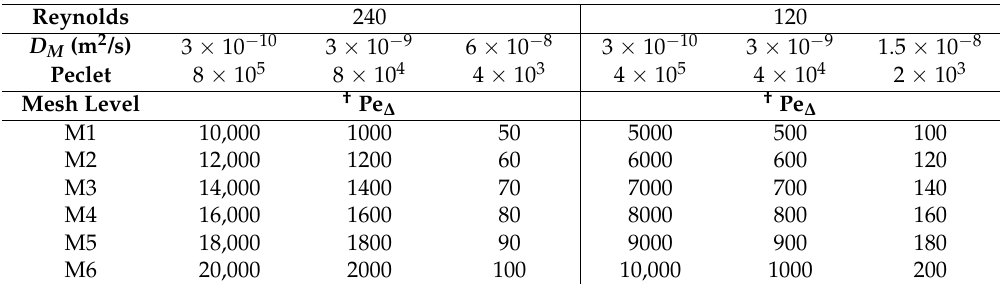
Table 2. Test cases for two-inlet and four-inlet micromixer designs.